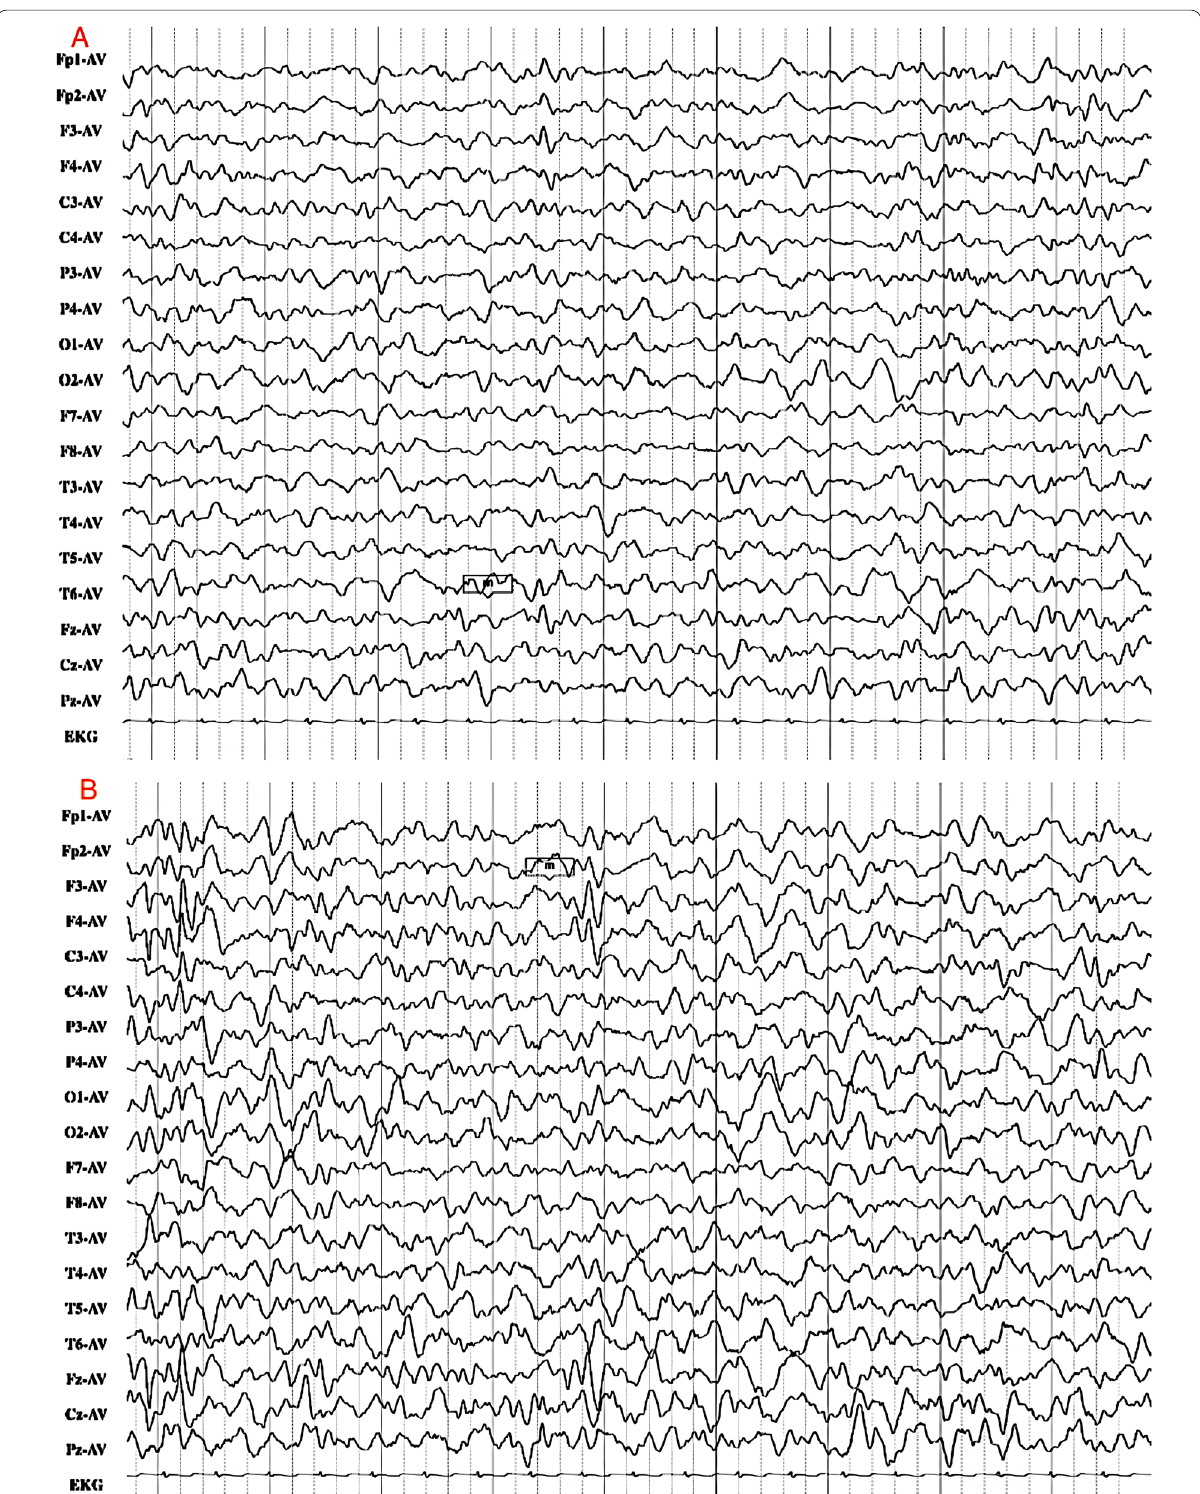
Fig. 2 EEG at age 10 months (on October 22, 2019). After 2 months of TPM treatment, the atypical sharp waves were occasionally seen in the bilateral frontal and frontal midline regions during